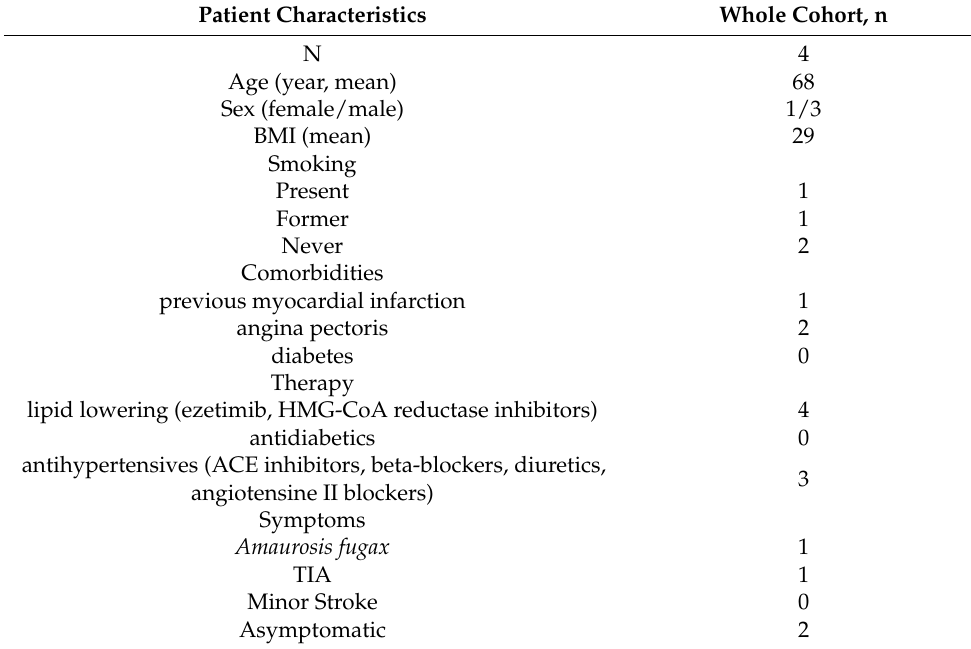
Table 1. Demographics of patients included for CTA and in silico analysis.